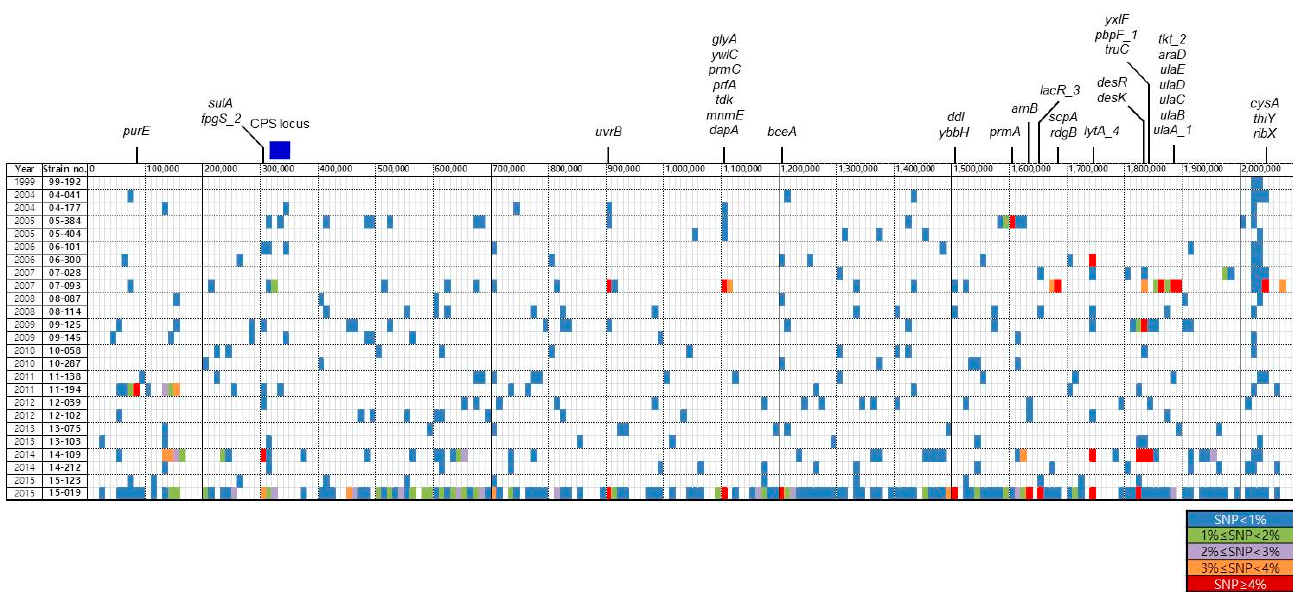
Figure 1. Distribution of genes showing sequence variation. The colored blocks indicate the genes showing sequence variations compared with isolate 99-176. It is represented regardless of the length of the genes. The color was marked differently depending on the degree of variation. The genes showing SNP rates ≥ 4% are shown at the top of the figure. The location of the CPS locus is indicated by a blue box. SNP, single nucleotide polymorphism; CPS, capsular polysac- charide.